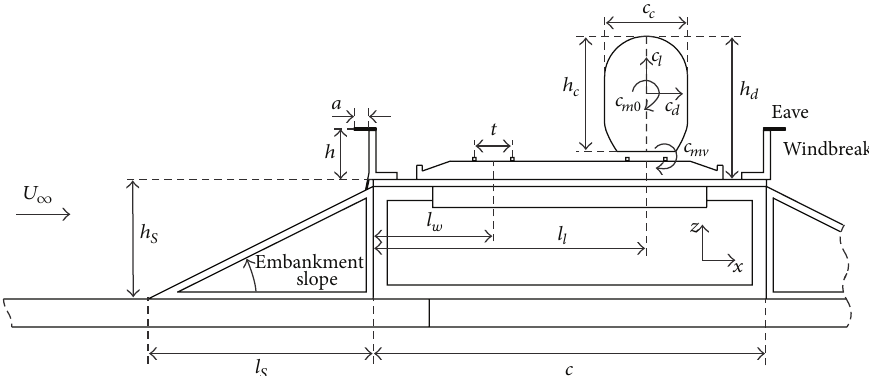
Figure 1: Sketch of the tested configuration: embankment and the twin railway track model equipped with windbreaks. Coefficients 𝑐 𝑙 , 𝑐 𝑑 , and 𝑐 𝑚 V (lift, side force, and rolling moment) are also indicated.